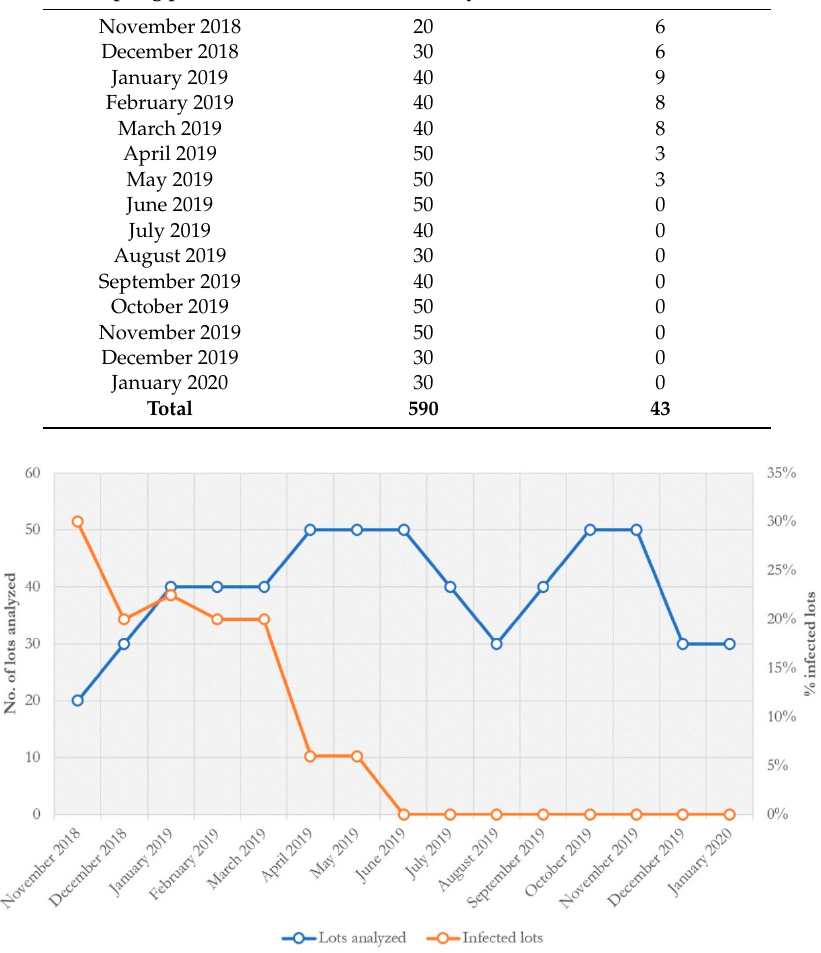
Figure 1. Number of lots of tomato seeds analyzed per month, during the period November 2018–January 2020 and percentage of ToBRFV-infected